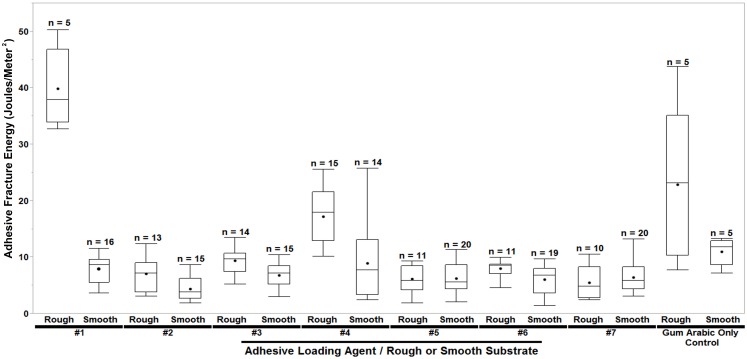
Box and whisker plots of Phase 2 results by adhesive loading agent and substrate condition classes.The horizontal line in each box indicates the median adhesive fracture energy for that class and the solid dot indicates the mean adhesive fracture energy for that class.